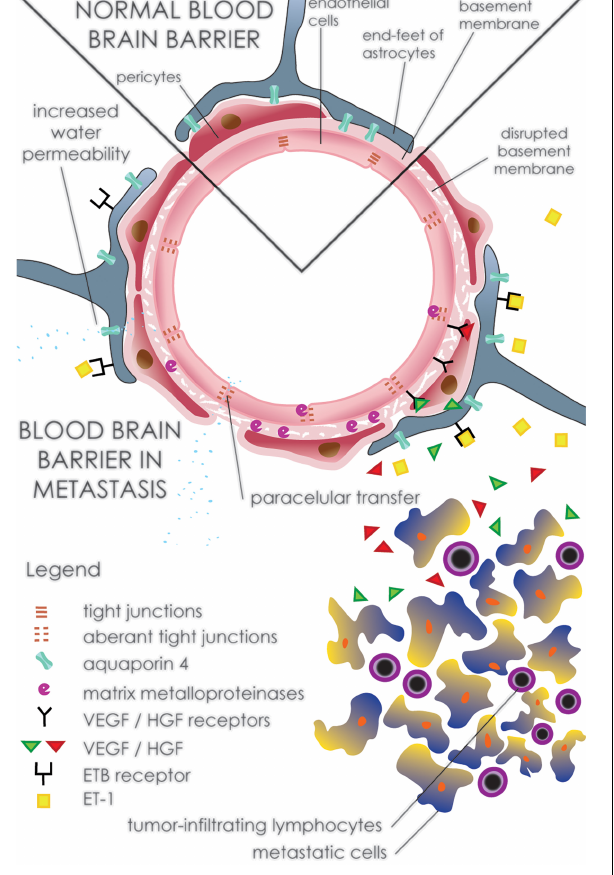
FIGURE 4 | Disruption of the peritumoral blood-brain barrier in brain metastasis. Expression of VEGF and SH/VEGF by metastatic cells leads to alteration in TJ proteins such as occludin, claudin-1, and claudin-5 resulting in increased paracellular water influx. In addition to metastatic cells, tumor-infiltrating lymphocytes contribute to the production of VEGF as well as some cytokines including IL-2. Degradation of TJ proteins and the basal membrane is also potentiated by increased expression of matrix metalloproteinases such as MMP-2 and MMP-9. Activation of metalloproteinases is induced by overexpression of ET-1, which leads to up-regulation of ROS and eNOS. Increased expression of AQP4, a part of the glymphatic system on astrocytic endfeet around metastatic lesions, contributes to the development of vasogenic edema by the accumulation of CSF into the brain